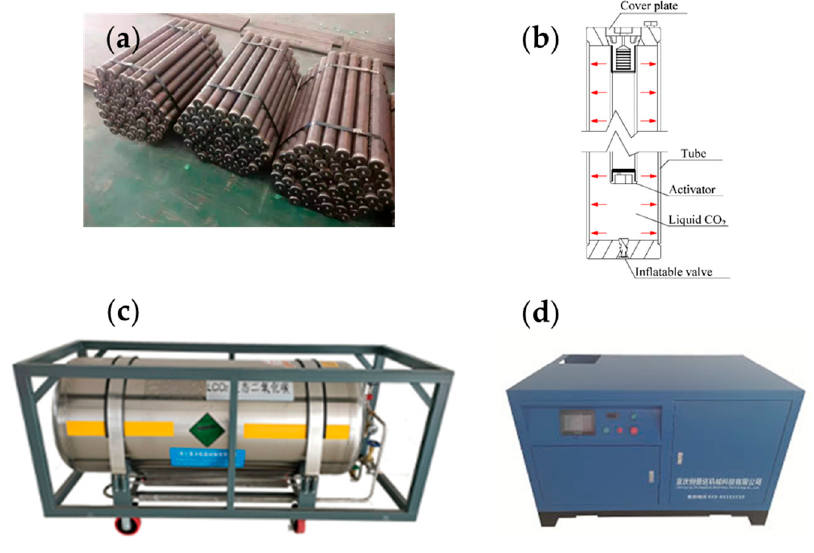
Figure 1. L-CDRB system: ( a ) fracturing tube; ( b ) tube’s construction; ( c ) liquid carbon dioxide stor- age equipment; ( d ) fi lling